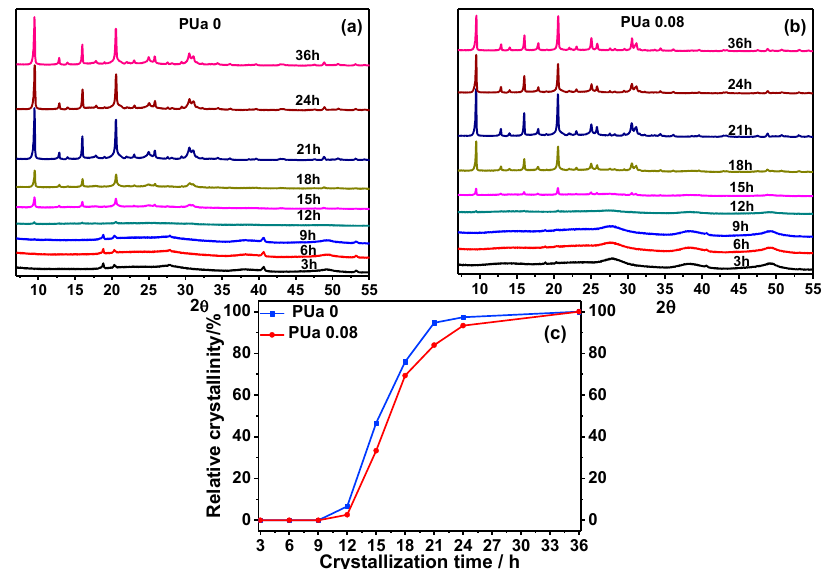
Figure 10. Time-dependent XRD patterns of ( a ) PUa 0 , ( b ) PUa 0.08 , ( c ) relative crystallinity evolution with crystallization time.